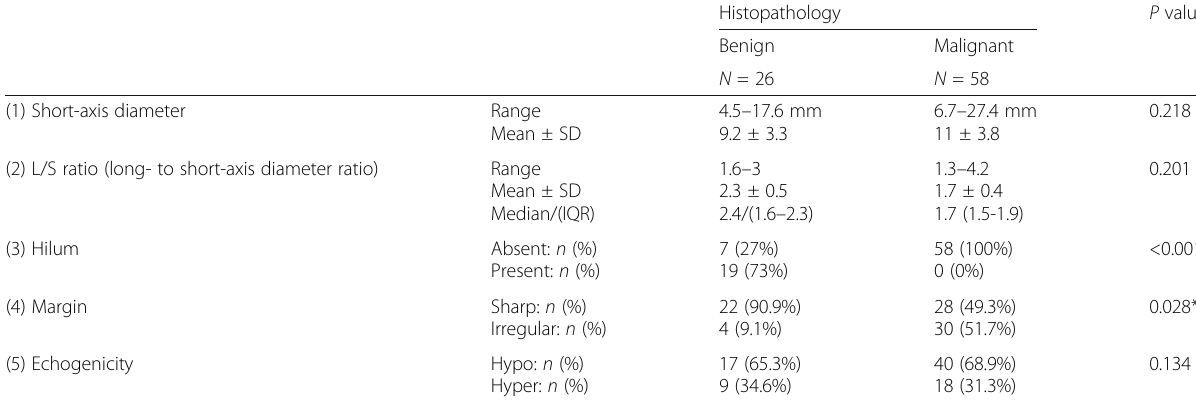
Table 1 Relation between the five used B-mode ultrasound criteria and final histopathological diagnosis